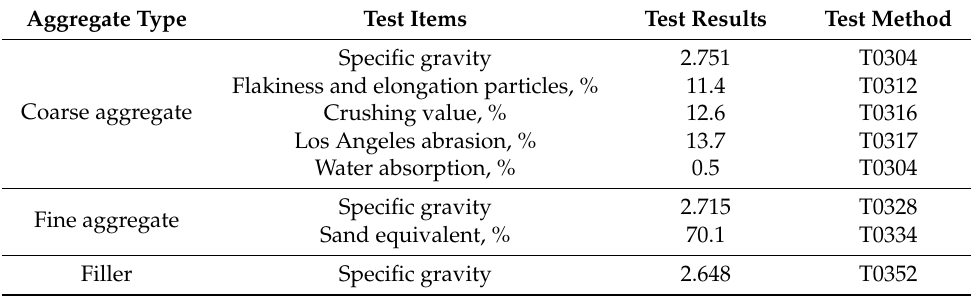
Table 2. Performance indexes of virgin aggregate.